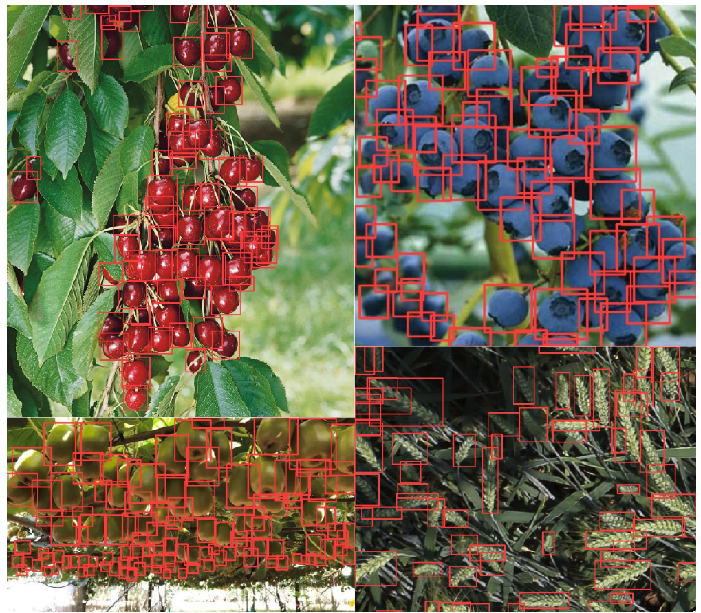
Figure 14. Four newly added fruits/crop prediction results using Yolov5x and RGB test images. Images are obtained from Google Images and Kaggle wheat detection competition (https://www. kaggle.com/c/global-wheat-detection) (accessed on 17 June 2022).